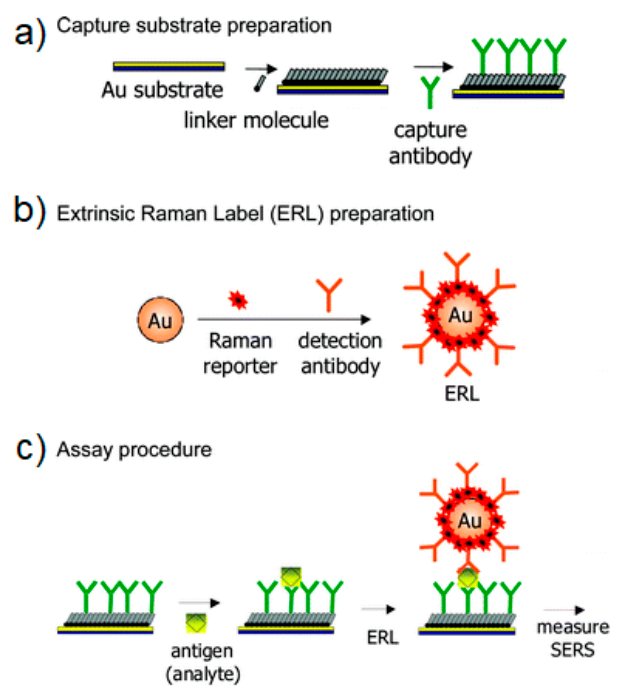
Figure 42. Steps involved in a SERS experiments based on an immunoassay. Reproduced with permission from Porter et al. [425]. ( a ) The substrate is functionalized with a capture antibody; ( b ) The SERS tag is synthesized by assembling a plasmonic core, a Raman reporter and a detection antibody; ( c ) In the assay procedure, the antigen (analyte) is sandwiched in between the SERS tag and the substrate. Copyright (2008), the Royal Society of Chemistry.